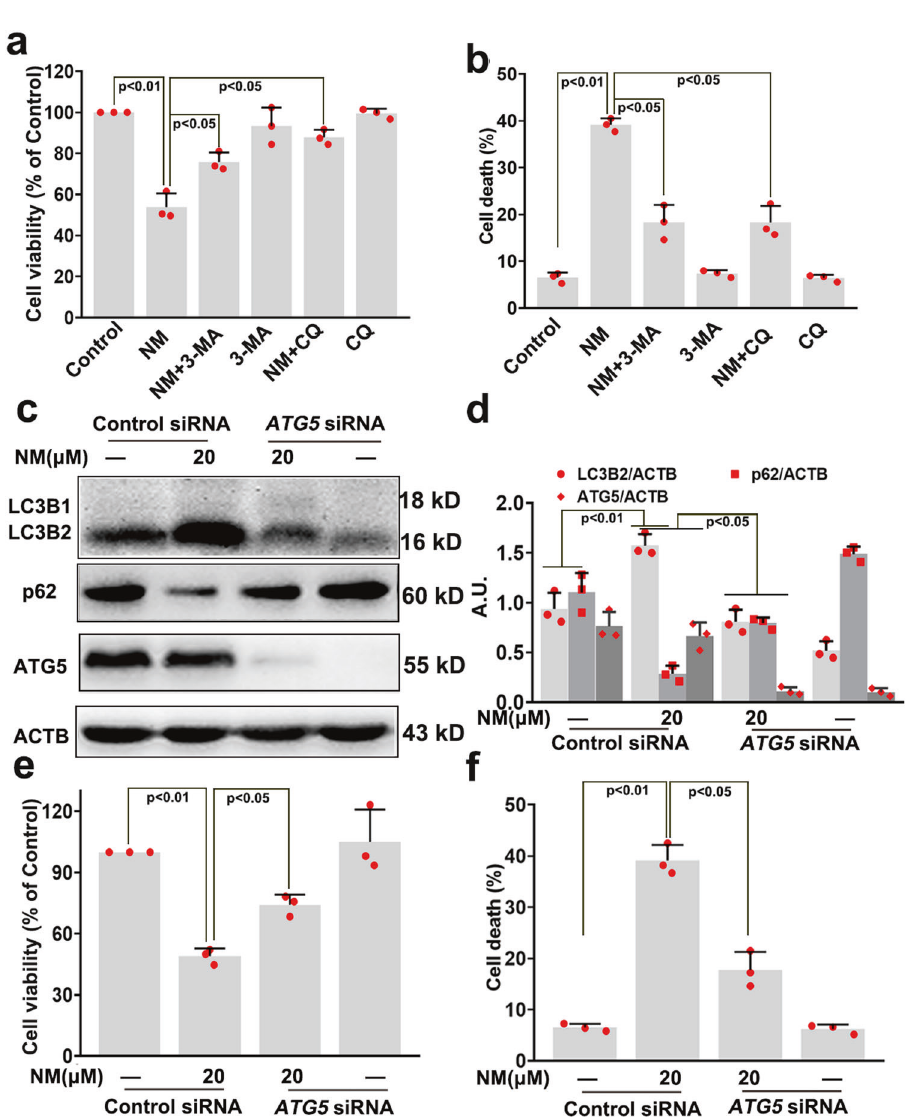
Fig. 3 The overactivation of autophagy contributed to NM-induced keratinocyte cell death. Cells were pretreated with 3-MA (5 mM) and CQ (5 µM) for 1 h, followed by treatment with NM (20 µM) for another 24 h. a Cell viability was measured by a CCK-8 detection kit and b cell death was detected with PI staining by fl ow cytometry. c ATG5 was knocked down by ATG5 siRNA as described in “ Materials and methods ” . At 24-h post-transfection, cells were treated with NM (20 µM) for 24 h. Cells were collected and lysed, and then western blot analysis was performed. d Bar charts show the quanti fi cation of the indicated proteins. Cells were treated as described in ( c ). Then ( e ) cell viability was measured by a CCK-8 kit and ( f ) Cell death was detected by PI staining followed by fl ow cytometry. Values are expressed as the mean ± SD ( n = 3); A.U. arbitrary